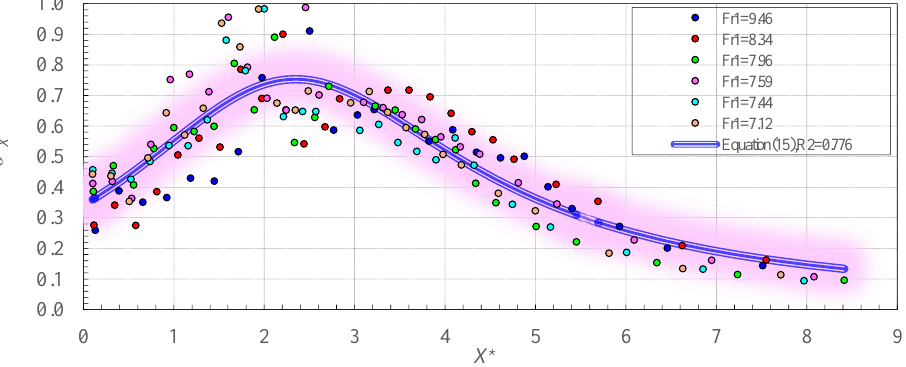
Figure 7. Distribution of σ * X , including the experimental data and Equation (15).